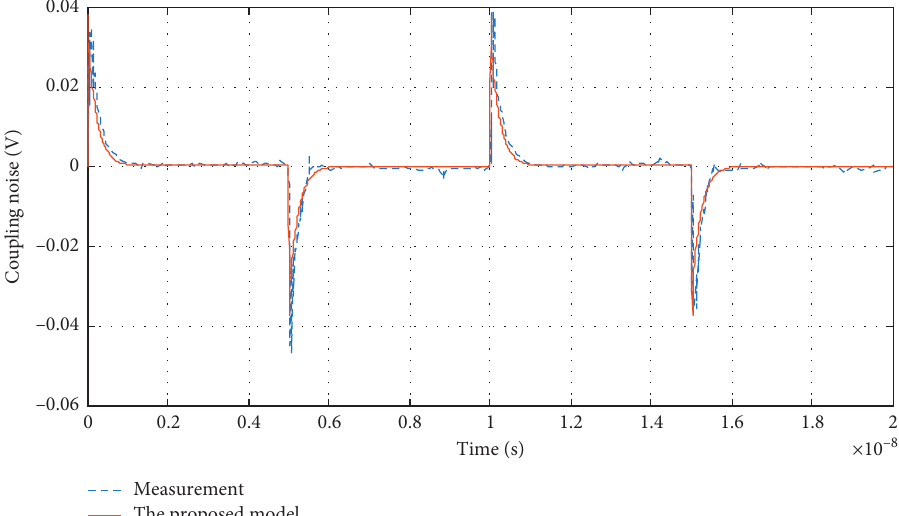
Figure 13: The proposed method and measured TSV-TSV coupling noise in the time domain (the input clock frequency at port 1 is